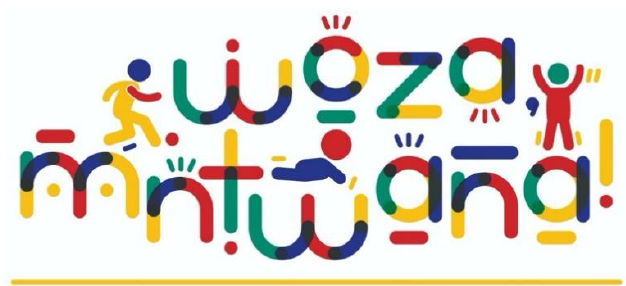
Figure 4. “Woza, Mntwana” campaign Figure 4. “ Woza, Mntwana” campaign logo.